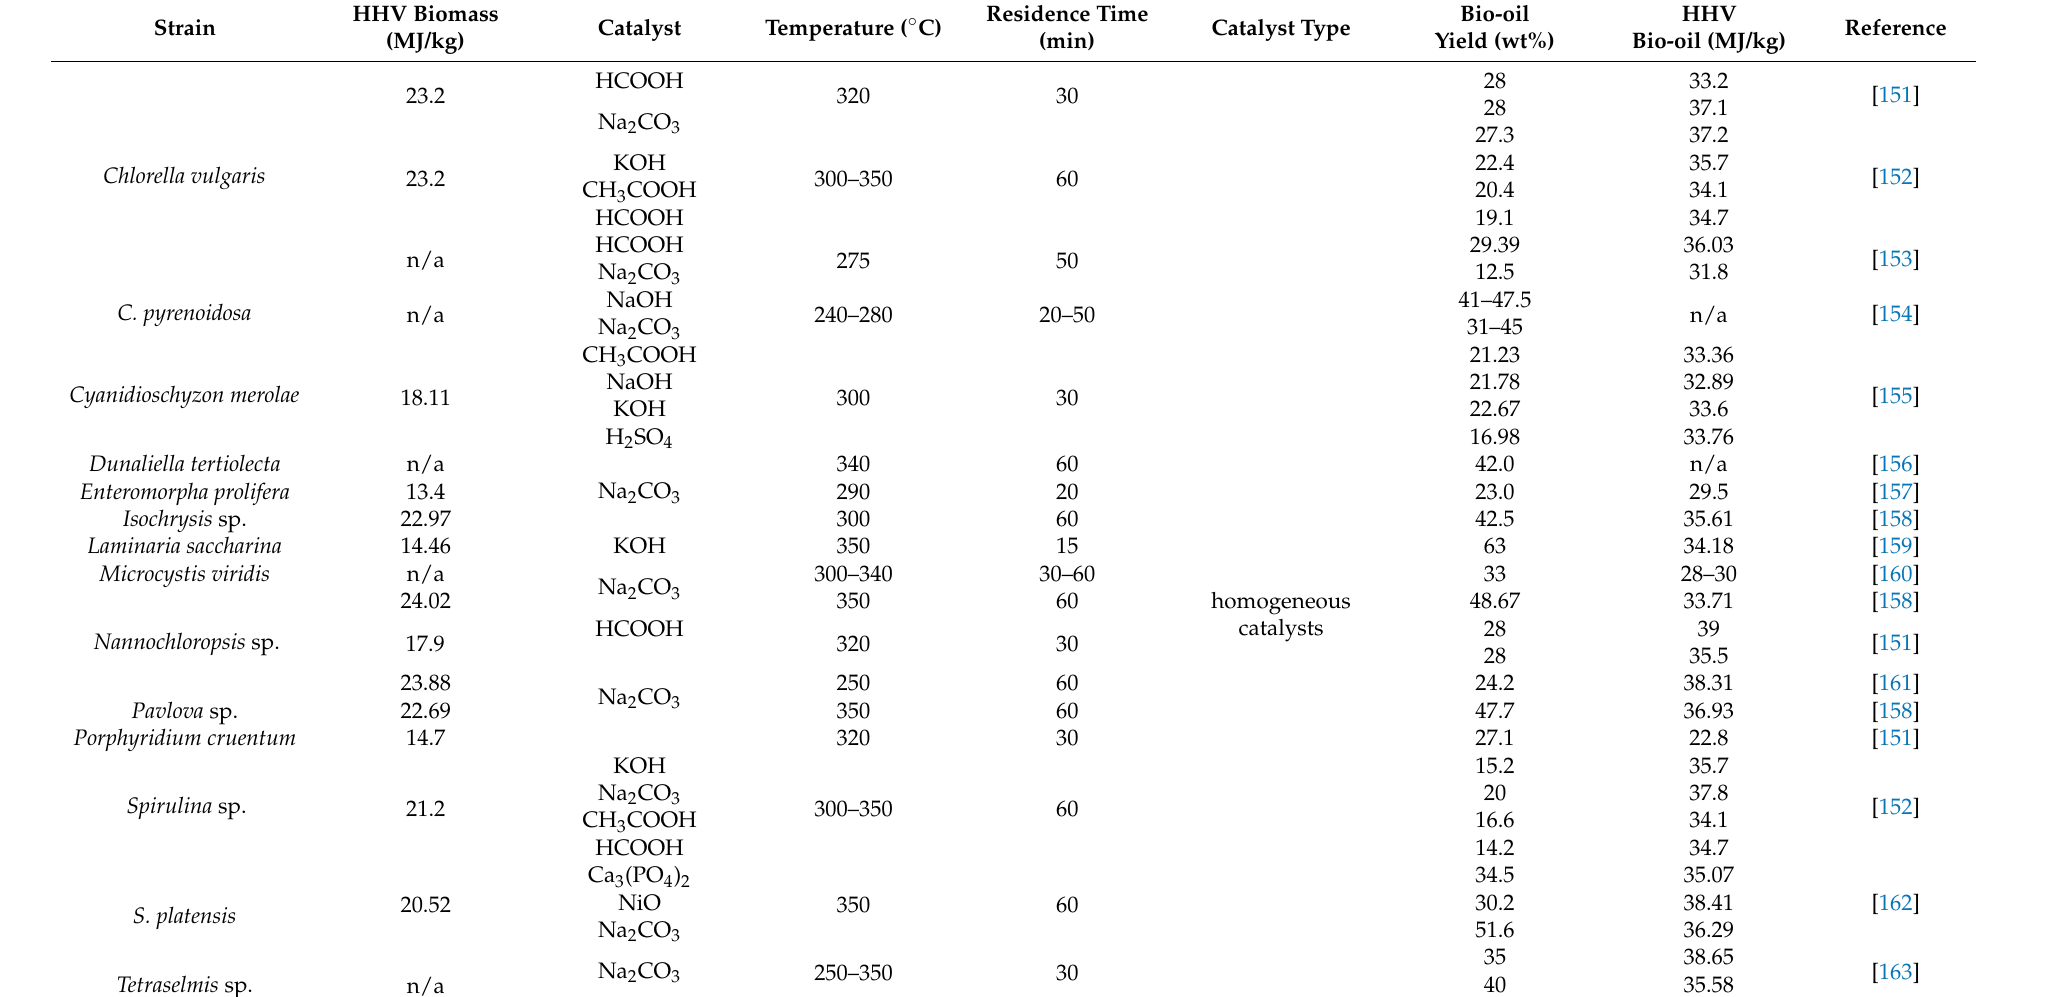
Table 3. Strains evaluated and their